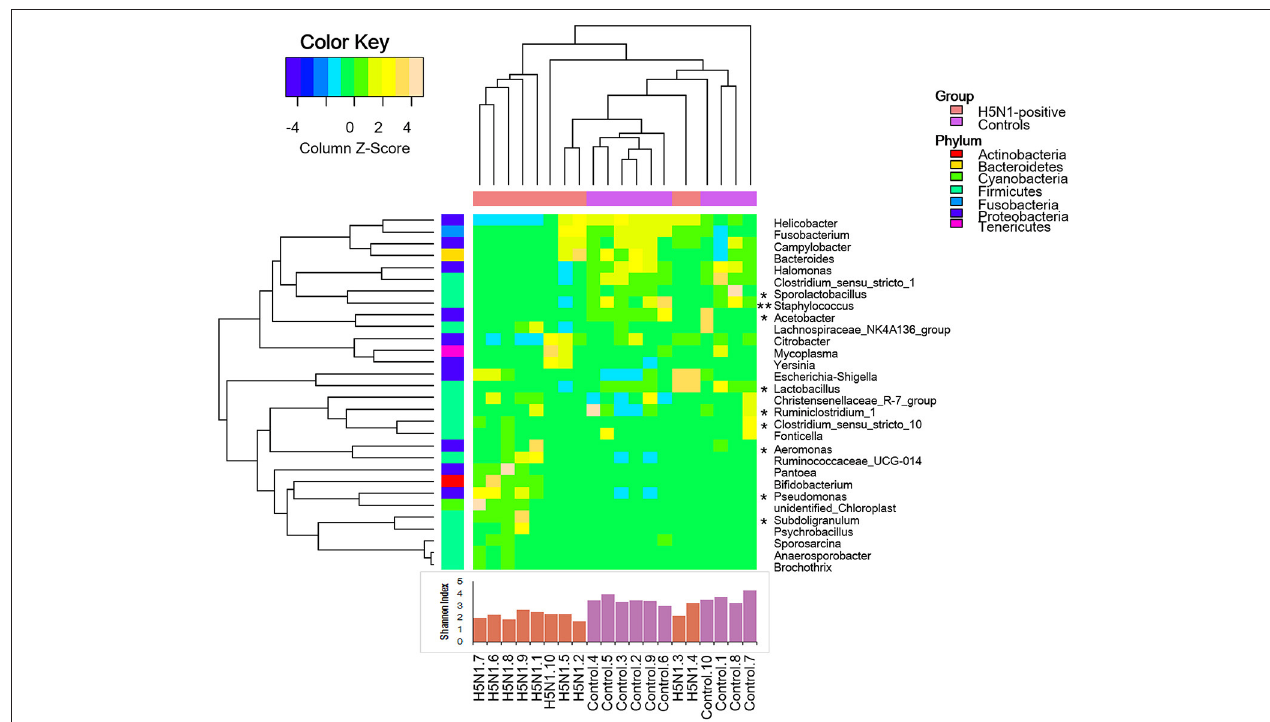
FIGURE 6 | Heatmap illustrating genus-level differences between the H5N1-infected individuals and the healthy controls. The relative abundance of each genus is indicated by a Z score, and a gradient of color from blue to yellow indicates the abundance, ranging from low to high. The gut microbiota was found to have a distinctive bacterial composition, which was also significantly associated with the Shannon index. * p < 0.05 and ** p < 0.01 by Mann-Whitney U